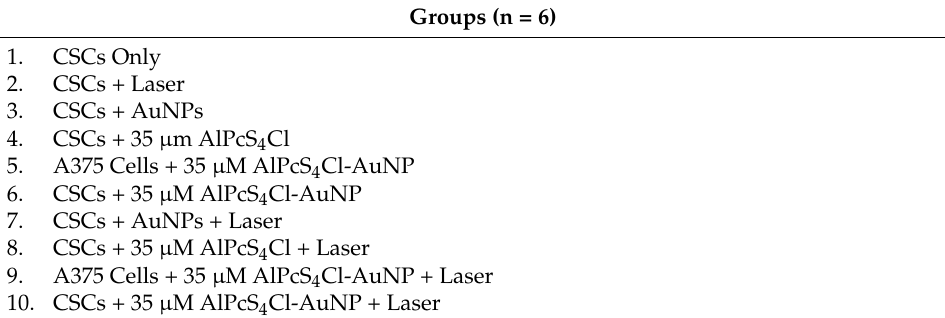
Table 1. A375 CSC cell categories.